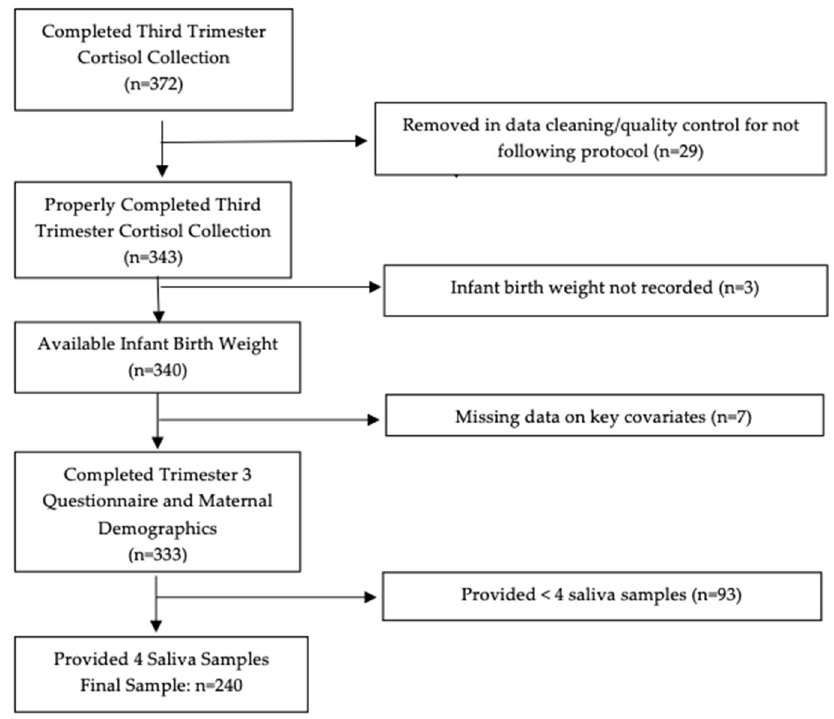
Figure 1. Consort diagram of included mother–infant dyads.